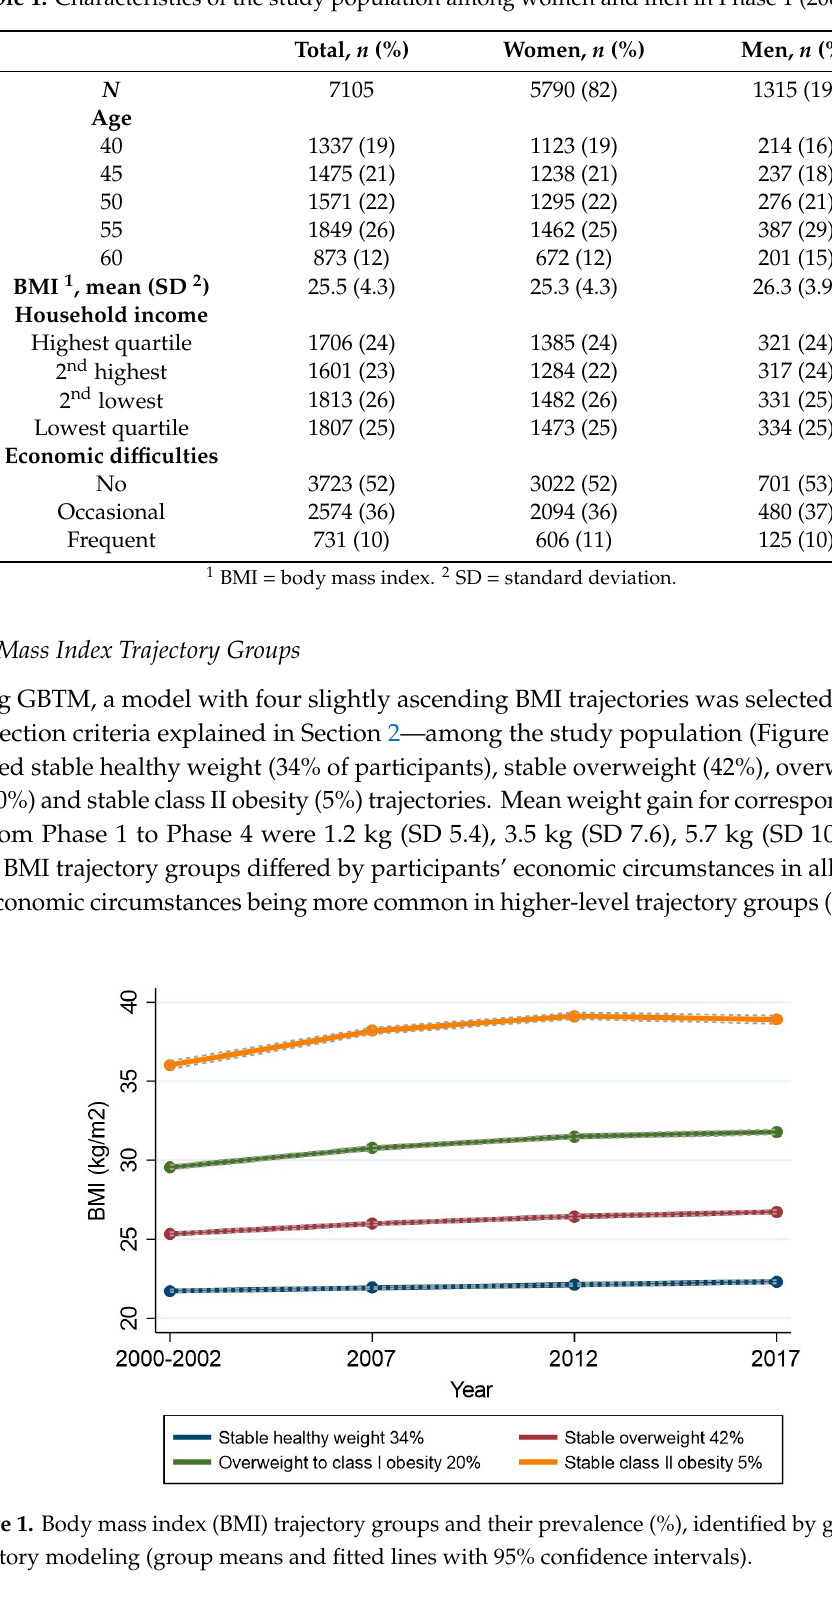
Table 1. Characteristics of the study population among women and men in Phase 1 (2000–2002).